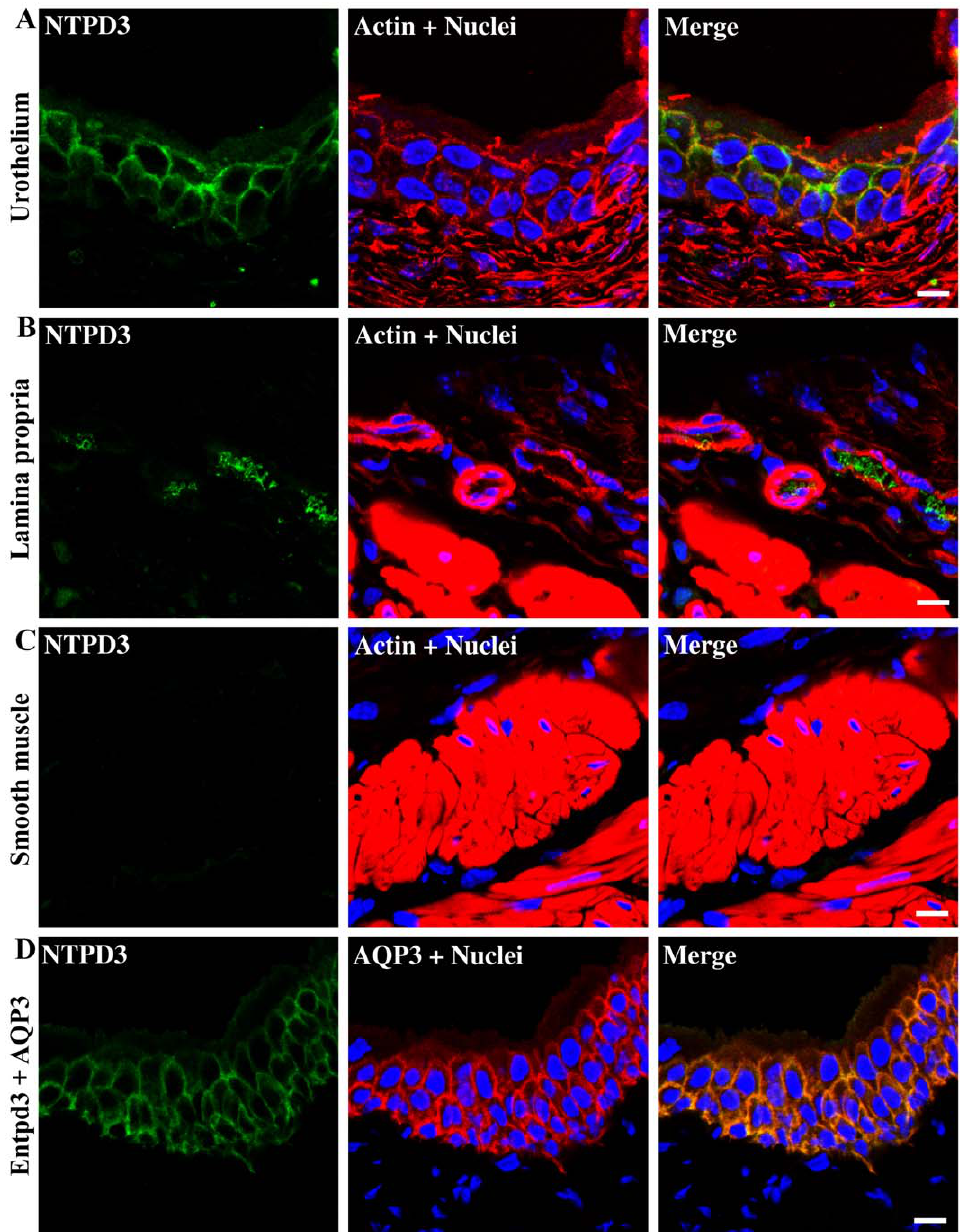
Figure 6. Immunolocalization of NTPD3 in different regions of the bladder. Cryosections of mouse bladders were labeled with antibodies to NTPD3 (green), rhodamine phalloidin to label the actin cytoskeleton (red) and Topro-3 to label nuclei (blue). Color merged panels are shown on the right. A) NTPD3 staining at the level of the urothelium, B) NTPD3 staining at the level of the lamina propria, C) NTPD3 staining at the level of the detrusor smooth muscle, D) NTPD3 staining with a different antibody from (A) at the level of the urothelium. Aquaporin 3 (AQP3), a marker of intermediate and basal cell plasma membranes colocalizes with NTPD3. White scale bars =10 m m.